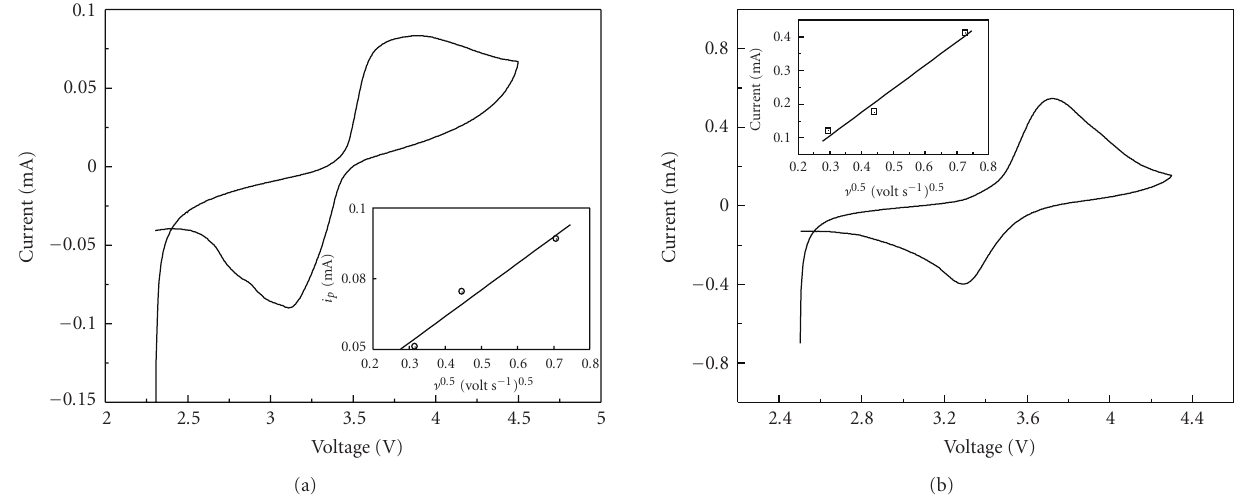
Figure 5: The CV profile of the di ff erent sample: (a) without carbon and (b) with carbon at the scan rate of 0.5 mVs − 1 .